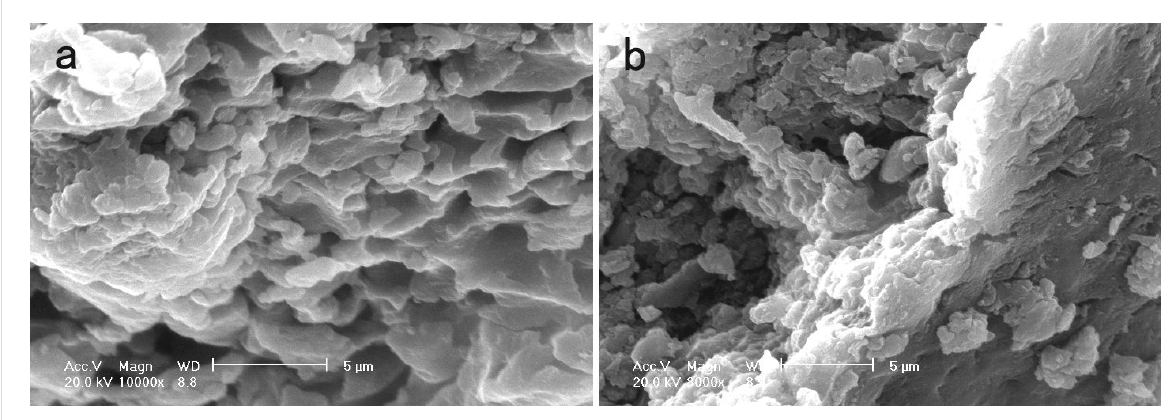
Figure 3: SEM images of the Cell–OPPh 2 (a) and the fresh catalyst Cell–OPPh 2 –Pd 0 (b).